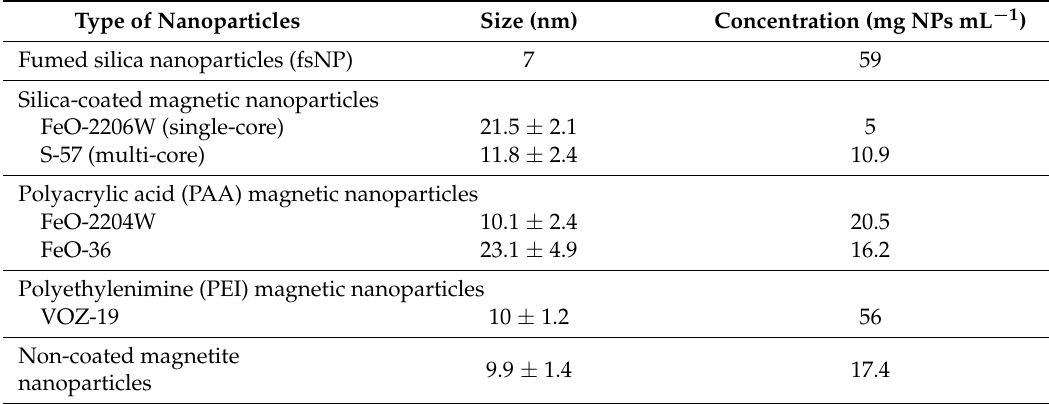
Table 1. Characteristics of the different